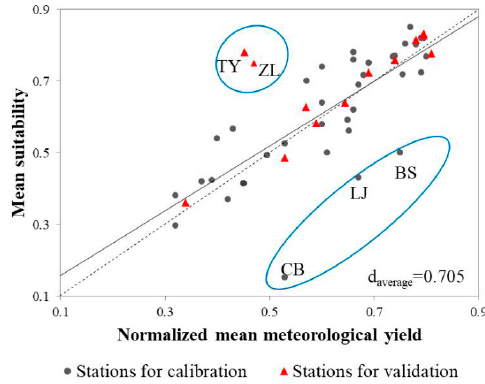
Figure 6. Comparison of scaled station mean meteorological yield and station mean suitability (calibration stations: gray dot; validation stations: red triangle; d < 0.6: blue circle; dotted line indicates 1:1 relationship).